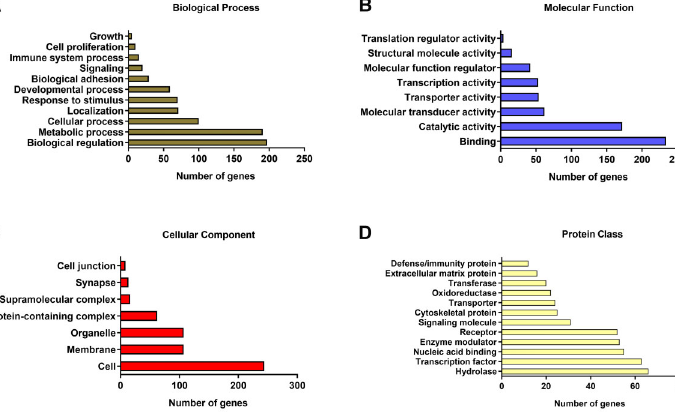
Figure 4. Gene Ontology (GO) functional annotations for differentially expressed genes (DEGs) of the AHOL1 cell line. Bar graphs show four GO categories: ( A ) Biological processes, ( B ) Molecular functions, ( C ) Cellular components, and ( D ) Protein classes. The X-axis represents the number of DEGs and the Y-axis shows the GO terms of each category (fold change X 2 and P o 0.05).